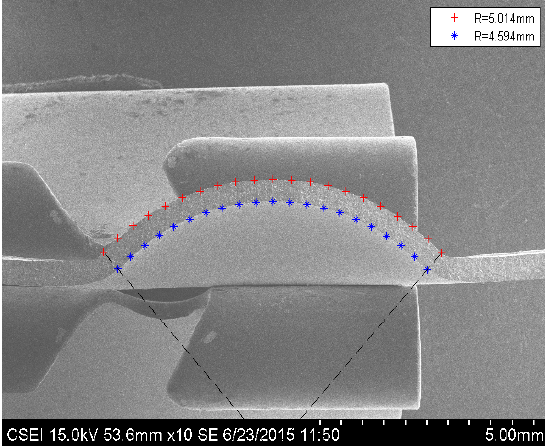
Figure 7. The stainless-steel specimen section at 100 MPa.